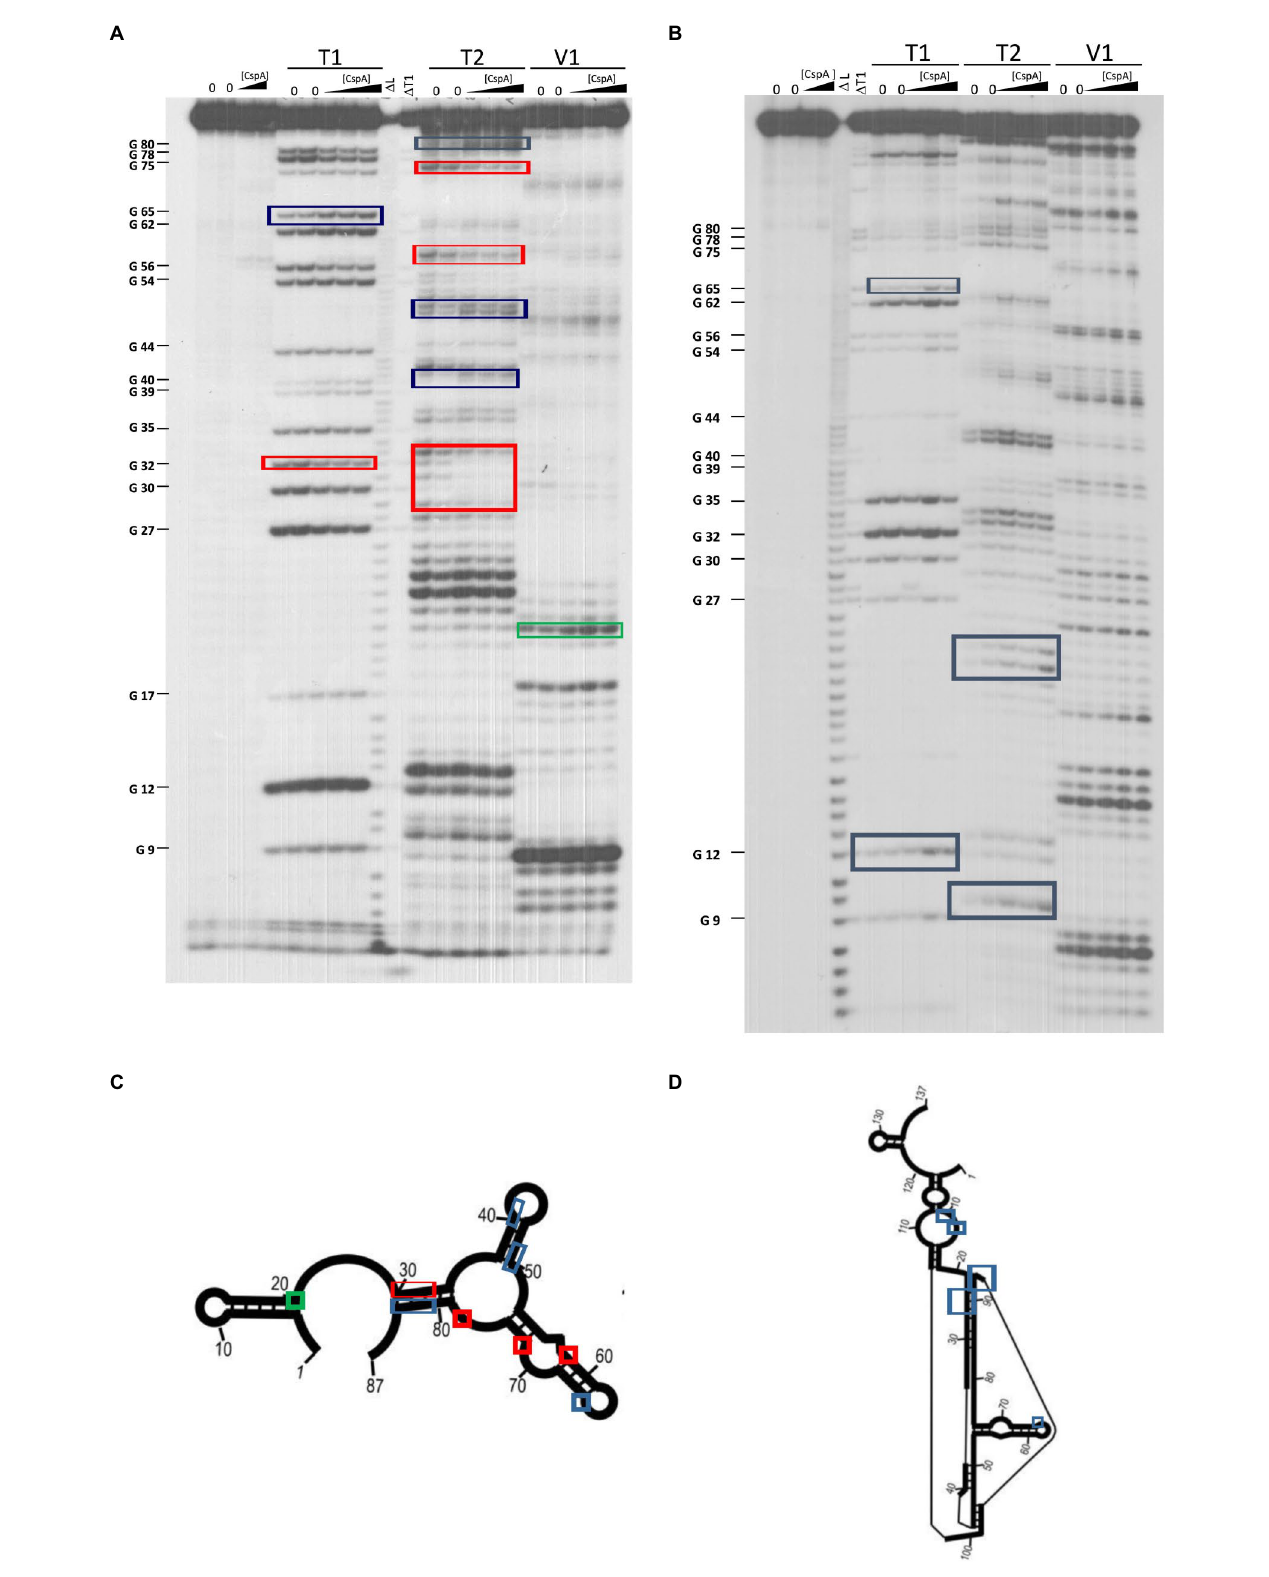
FIGURE 4 Footprinting experiments of fragments 87cspA and 137cspA RNAs. (A) Short electrophoretic migration of the fragments generated by RNase T1 (T1), RNase T2 (T2), or RNase V1 (V1) digestion of 5 ′ -end [ 32 P]-labelled (A) 87cspA RNA and (B) 137cspA RNA. The experiments were carried out in the absence (lanes 0) or in the presence of 51, 81, and 105 μ M of CspA (increasing concentrations are indicated with a triangle). Lane Δ T: RNase T1 cleavages under denaturing conditions; lane Δ L: alkaline ladder. The red and blue boxes indicate the positions protected or exposed by CspA, respectively, while the green boxes indicate the V1 cuts enhanced by CspA. The same positions are reported on the schematic structural model (Giuliodori et al., 2010) of the 87cspA RNA (C) or of the 137cspA RNA (D)